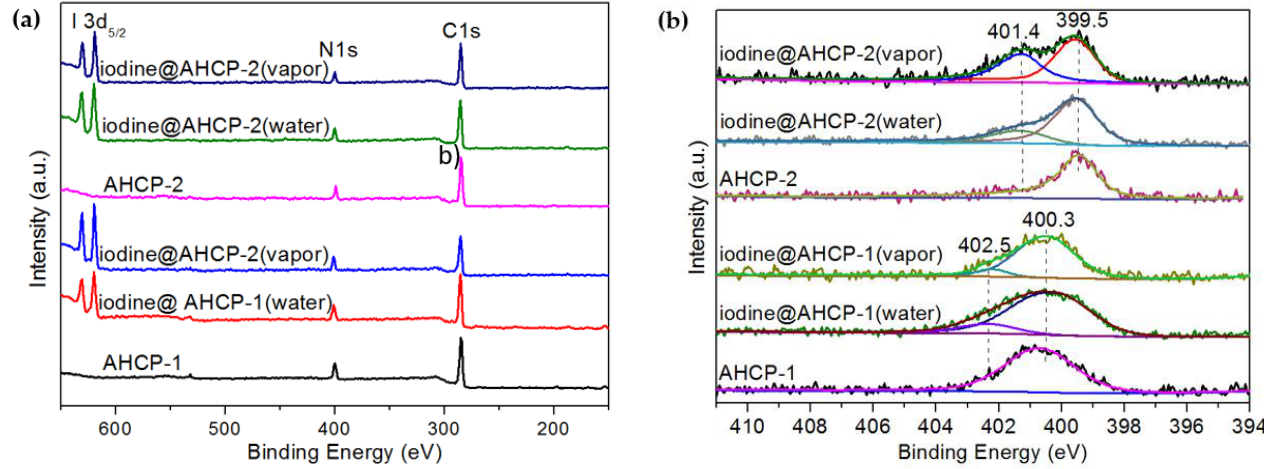
Figure 5. XPS spectra of AHCPs: iodine@AHCPs(water) and iodine@AHCPs(vapor). ( a ) The survey spectra and ( b ) high-resolution N1s.